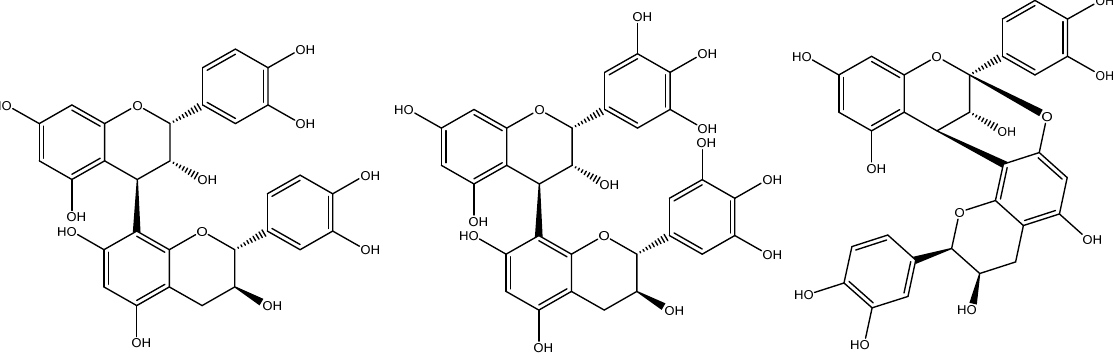
Figure 7. Chemical structures of B-type procyanidins ( left ) characteristic of grape seed, grape skins prodelphinidins ( centre ), and A-type procyanidins ( right ), often found in peanut skin and pine bark.